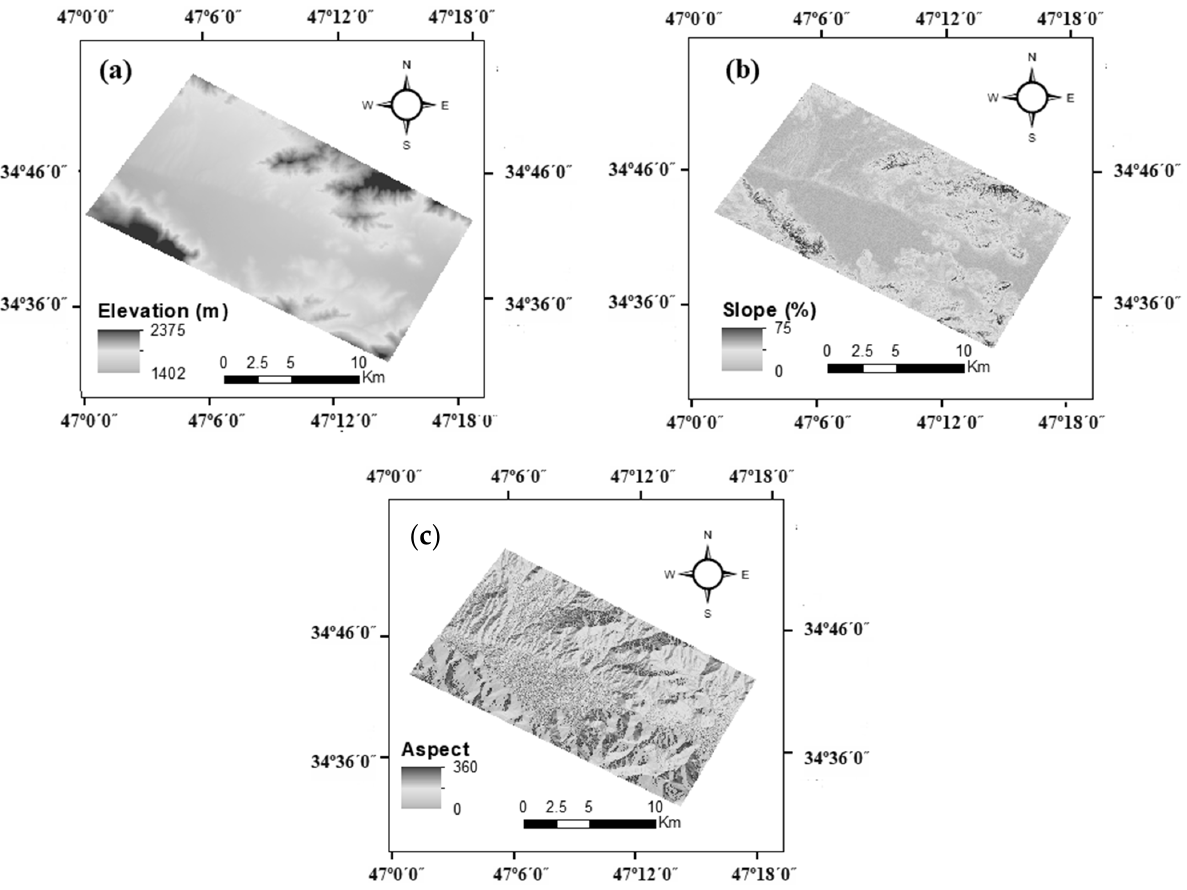
Figure 2. Maps of the ( a ) elevation, ( b ) slope, and ( c ) aspect of the study